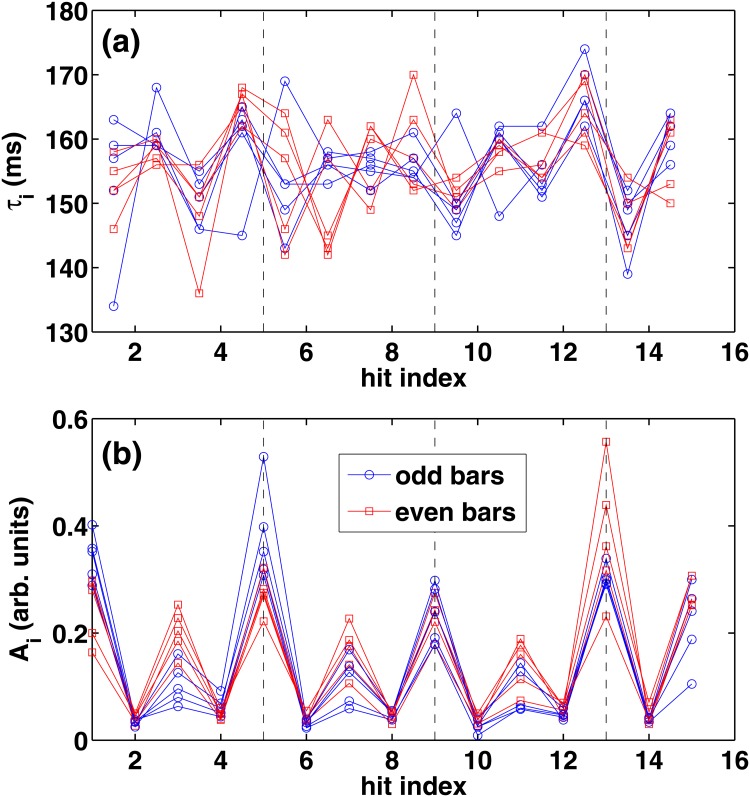
(a) 16th note interbeat intervals during the first 10 bars in “I Keep Forgettin”’. Each bar consists of 16 hits, and the corresponding intervals are marked at half-integer values. The interval between the 15th and 16th note is missing due to open hi-hats at the end of almost all bars (see text). The circles and squares correspond to odd (1, 3, …) and even (2, 4, …) bars, respectively. (b) Same as (a) but for the hit amplitudes. Again, the 16th hit is missing due to the open hi-hat—see the drum score in Fig 7.